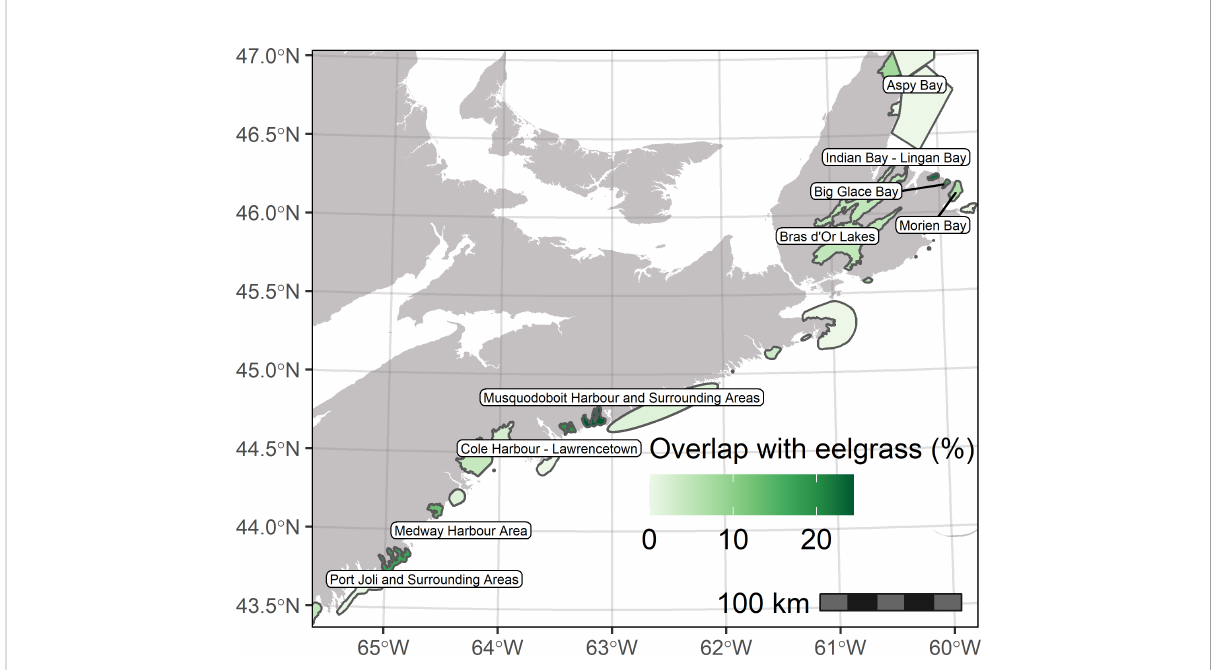
FIGURE 5 Overlap of predicted suitable eelgrass habitat from ensemble model with coastal Ecologically and Biologically Signi fi cant Areas (EBSAs) on the Atlantic coast of Nova Scotia. Colour shading of EBSA polygons denotes degree of overlap with deeper green shades indicating a higher percentage of the EBSA area covered by eelgrass